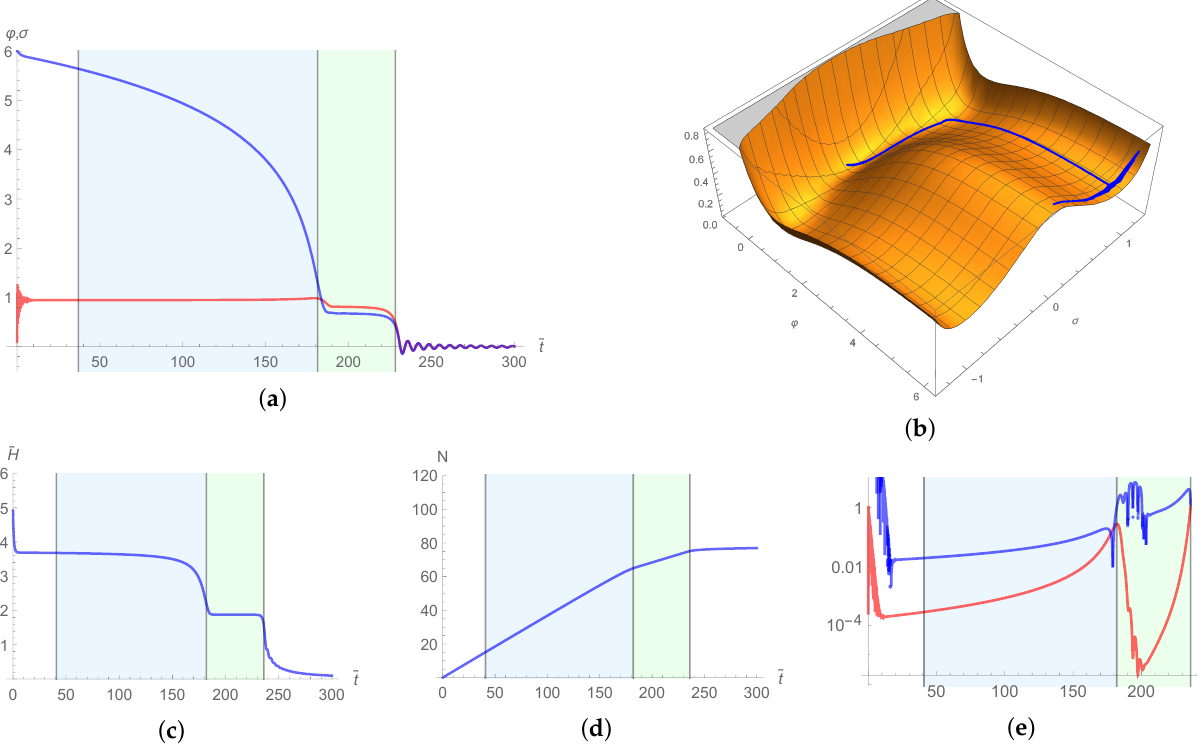
Figure 2. ( a ) The solution to the field Equations (52) and (53) with the initial conditions ϕ ( 0 ) = 6, σ ( 0 ) = 0.1; the vanishing initial velocities; and the parameters δ = 0, γ = 1, and ζ = − 1.7774. The blue shaded region represents the first stage of inflation, and the green shaded region represents the second stage of inflation. ( b ) The trajectory of the solution. ( c ) The corresponding Hubble function. ( d ) The e-folds. ( e ) The SR parameters (cid:101) (red) and η (blue). The CMB observables in this model (as the best fit) are given by n s ≈ 0.9600 and r max ≈ 0.004